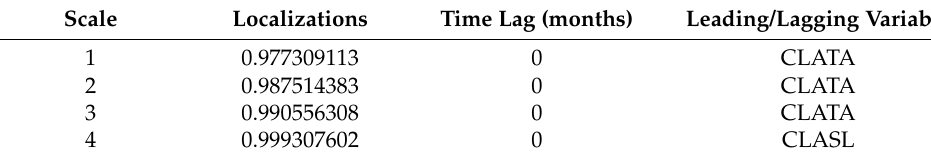
Table 3. WMCC GSE and banking sector financial